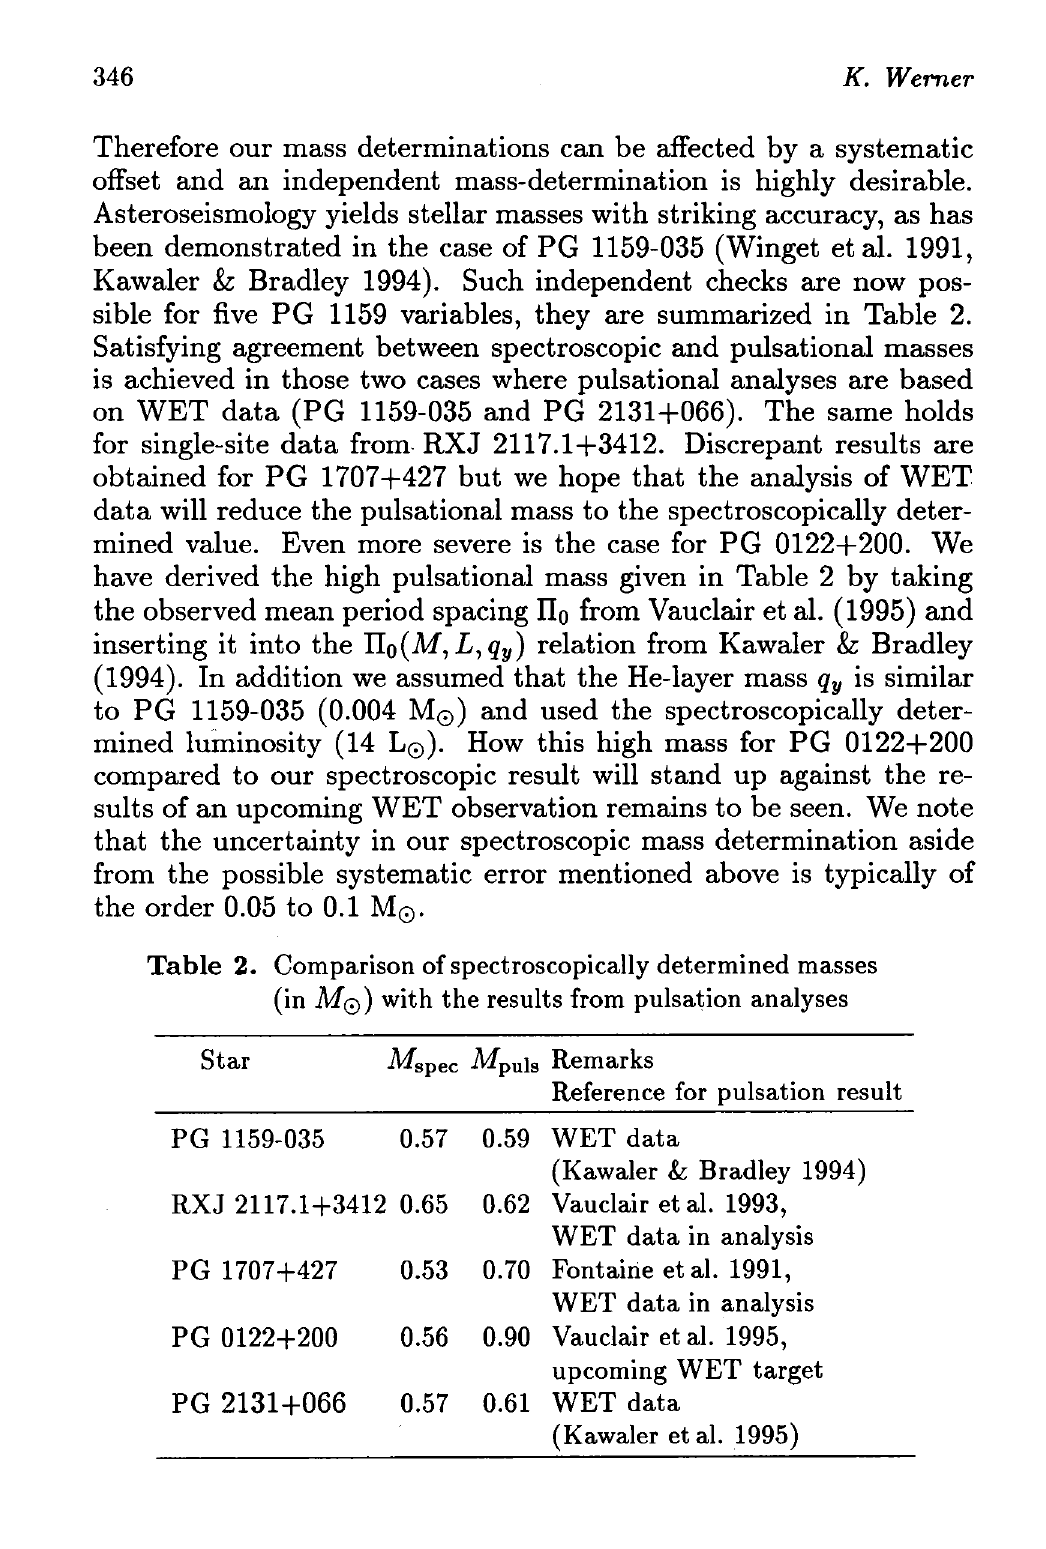
Table 2. Comparison of spectroscopically determined masses (in M©) with the results from pulsation